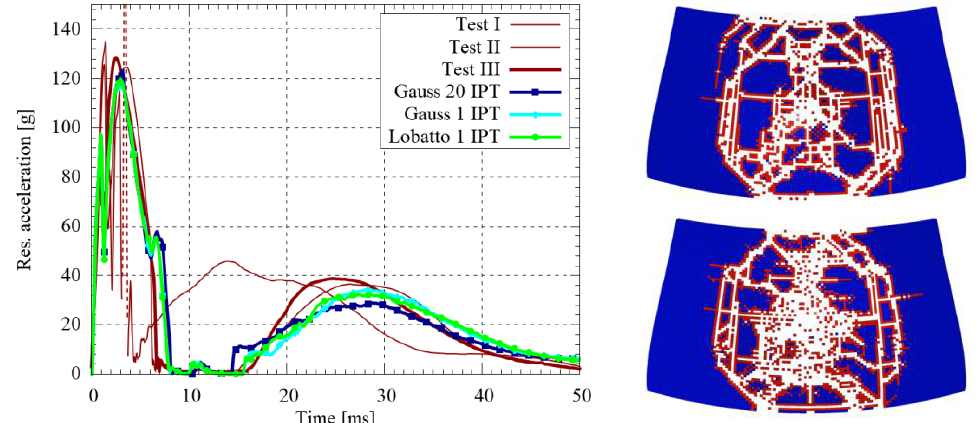
Figure 6. ( Left ) Resultant acceleration of three different tests in comparison with the simulation. ( Right ) Predicted fracture pattern for the two glass panes of the windshield, cf. [10] .